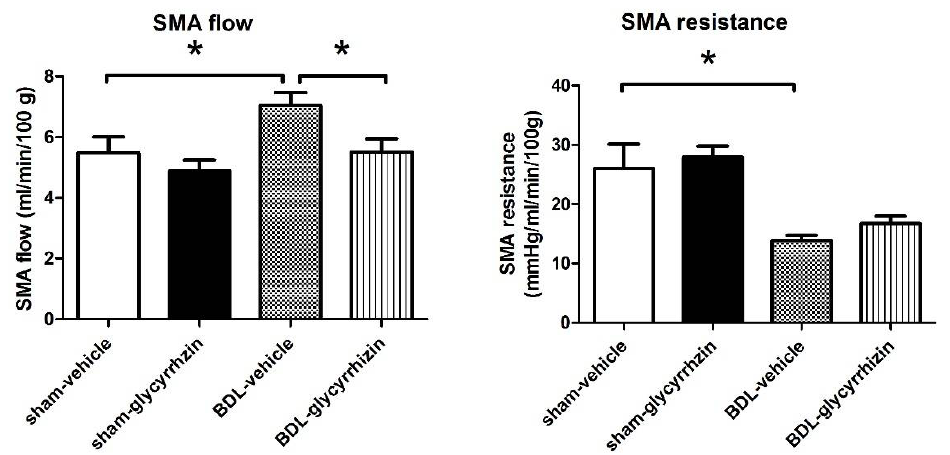
Figure 2. Effects of glycyrrhizin on splanchnic system. In rats with BDL-induced cirrhosis, the superior mesenteric artery (SMA) flow significantly increased compared with the sham-vehicle group. Glycyrrhizin significantly attenuated SMA flow in cirrhotic rats. The SMA resistance decreased in cirrhotic rats and was not affected by glycyrrhizin ( n = 6, 6, 6, 6; BDL, bile duct ligation). * p < 0.05